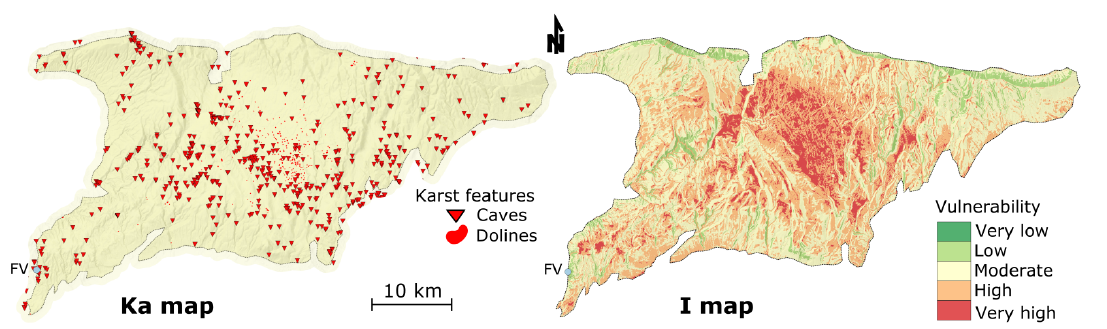
Figure 6. The two aquifer function criteria used in the PaPRIKa method for the study area. At the catchment scale, local variation of the Ka criteria could not represented; therefore a red triangle shows the locations of caves and red polygons depict